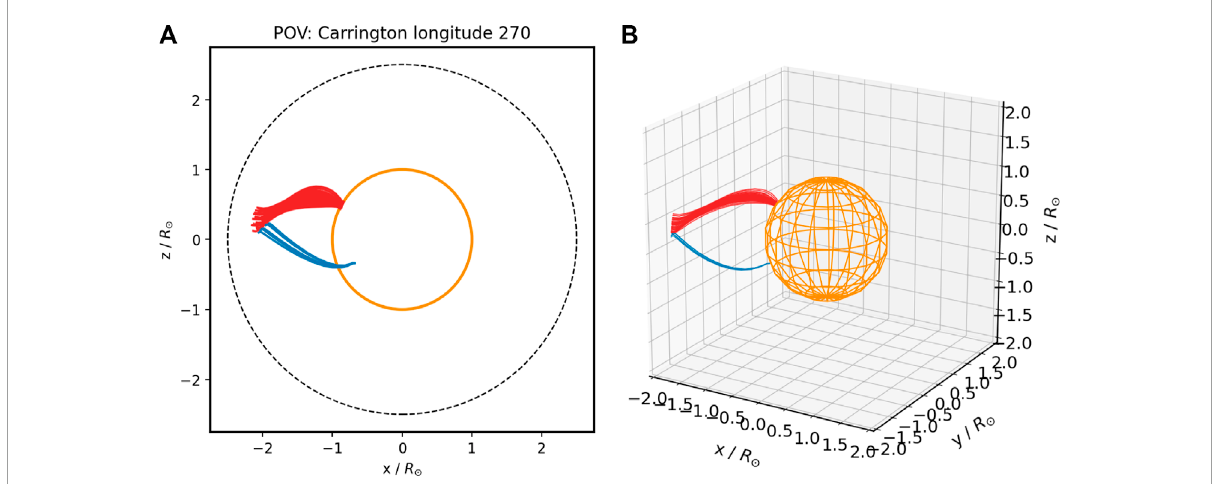
FIGURE 4 Detailed view of Earth’s magnetic connection from the PFSS backmapping example shown in Figure 3 . (A) Two-dimensional side view with the point of view (POV) at Carrington longitude 270 ° (i.e., the observer is located at six o’clock in Figure 3 ), (B) freely rotatable three-dimensional view. The two colors of the field lines indicate the corresponding magnetic